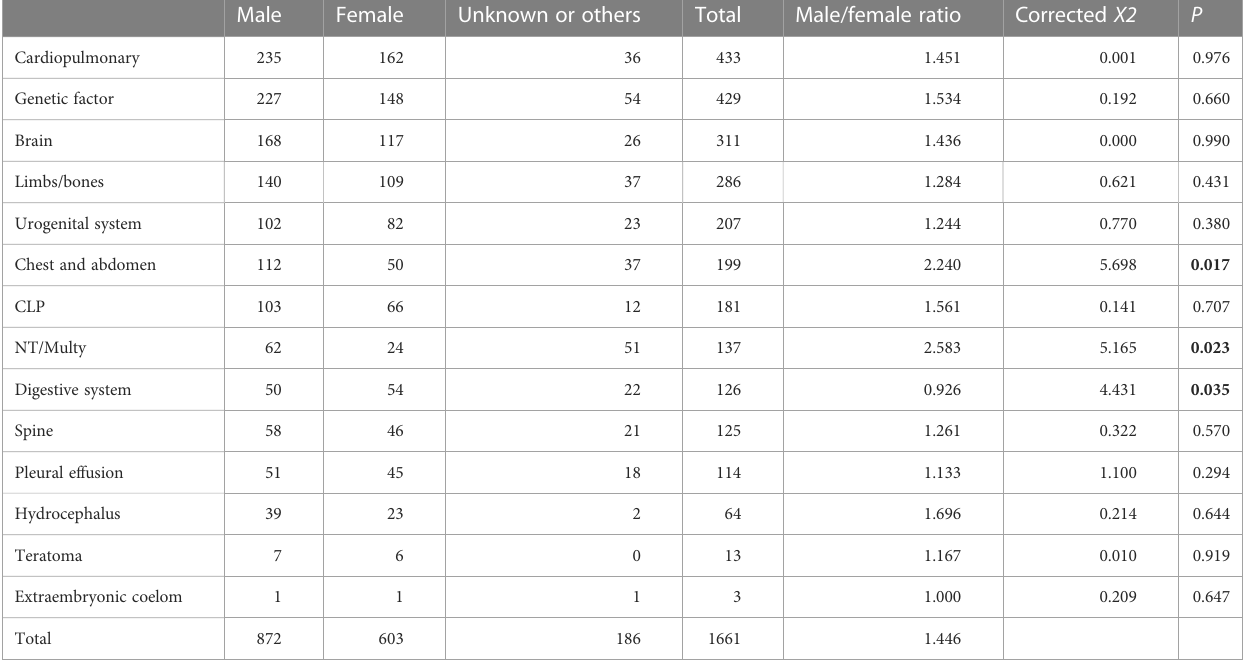
TABLE 1 Sex ratio of 13 types of structural malformations (Chi-squared tests applied to categorical variables, corrected X 2 ), P < 0.05